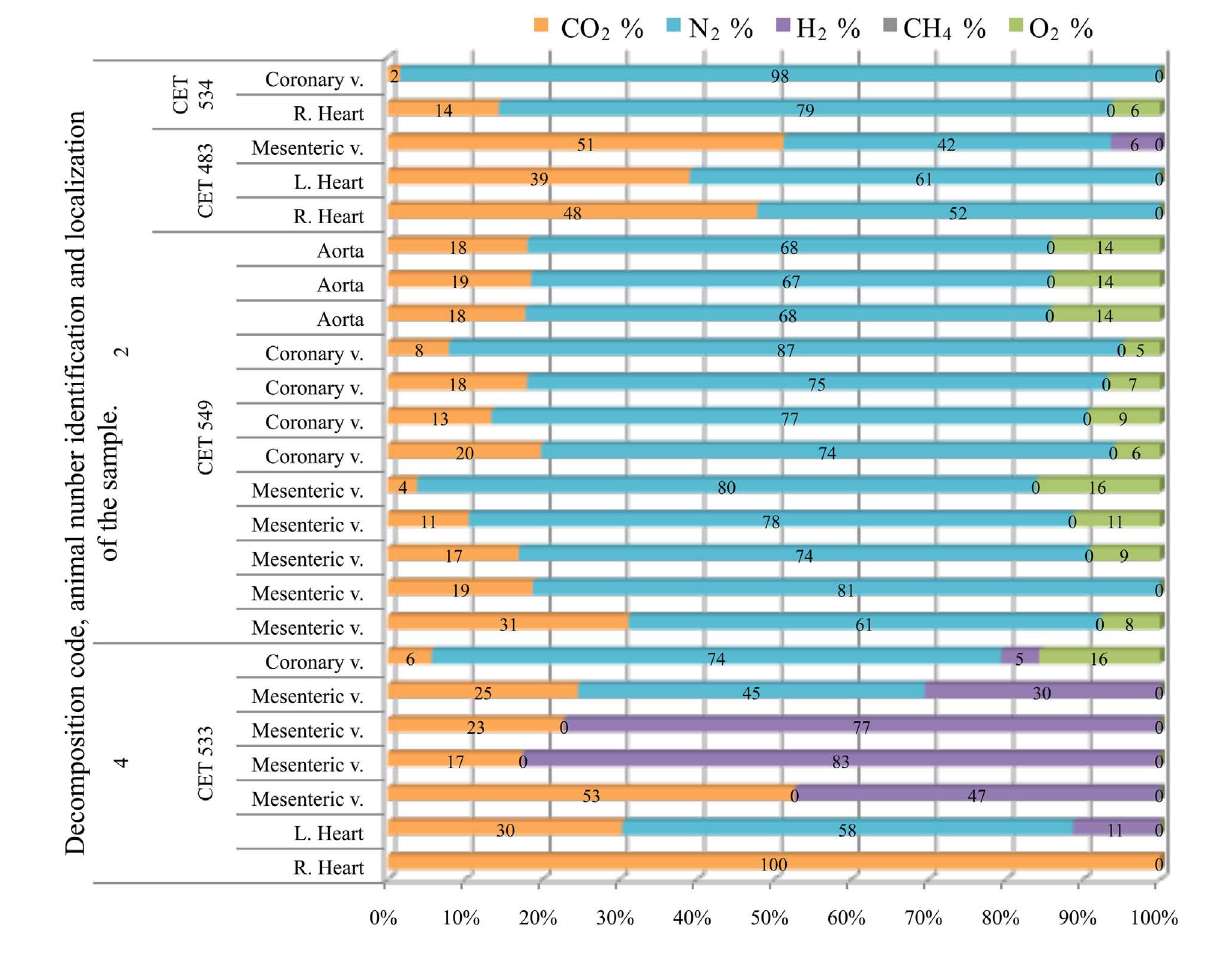
FIGURE 10 | Intravascular bubble’s gas composition of deep diving animals belonging to Grampus griseus specie in different tissues and decomposition codes, illustrating the contribution of each gas to the total amount in percentage μ